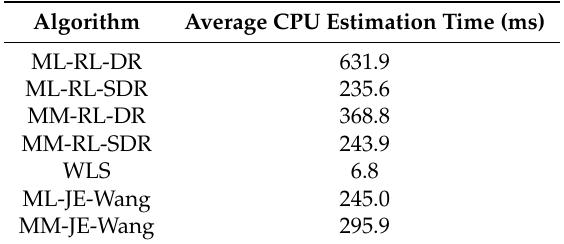
Table 2. Average CPU estimation time for different source localization algorithms for source localization.